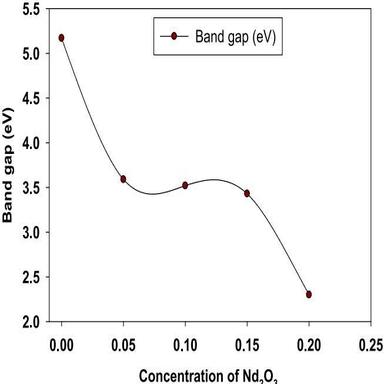
The influence of band gap (Eg) with the concentration of Nd2O3.